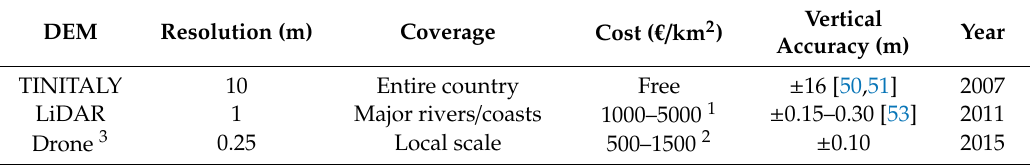
Table 1. Summary of specifications of the TINITALY, LiDAR, and UAV DEMs 1